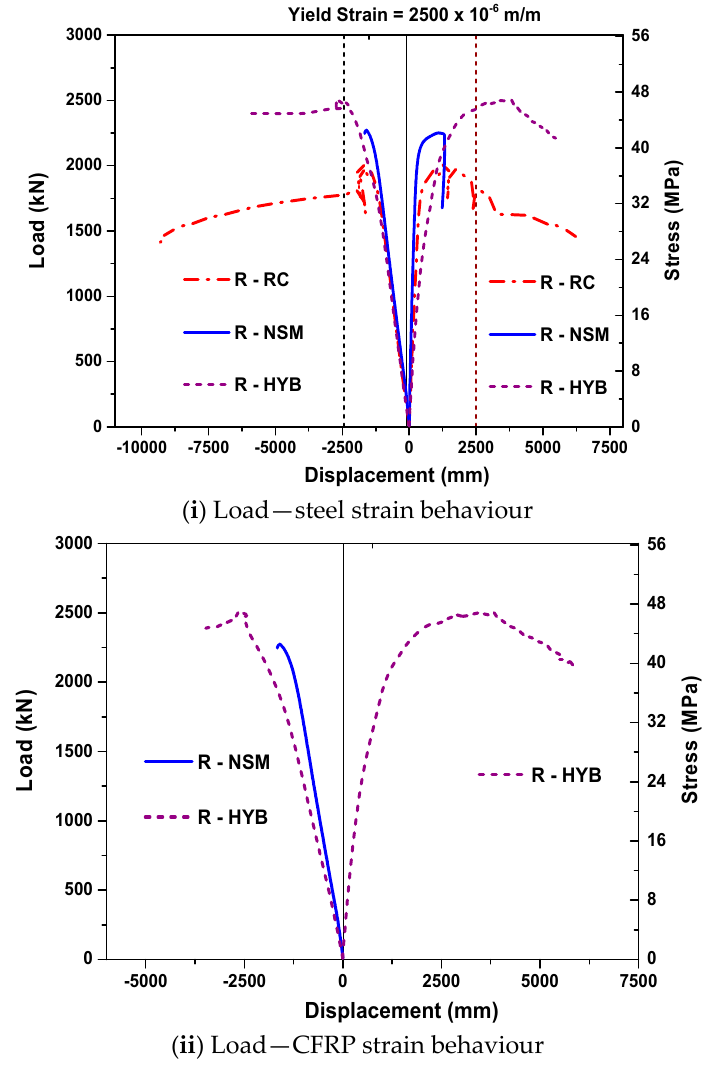
Figure 9. Load—strain behaviour of Pre-damaged RC columns.